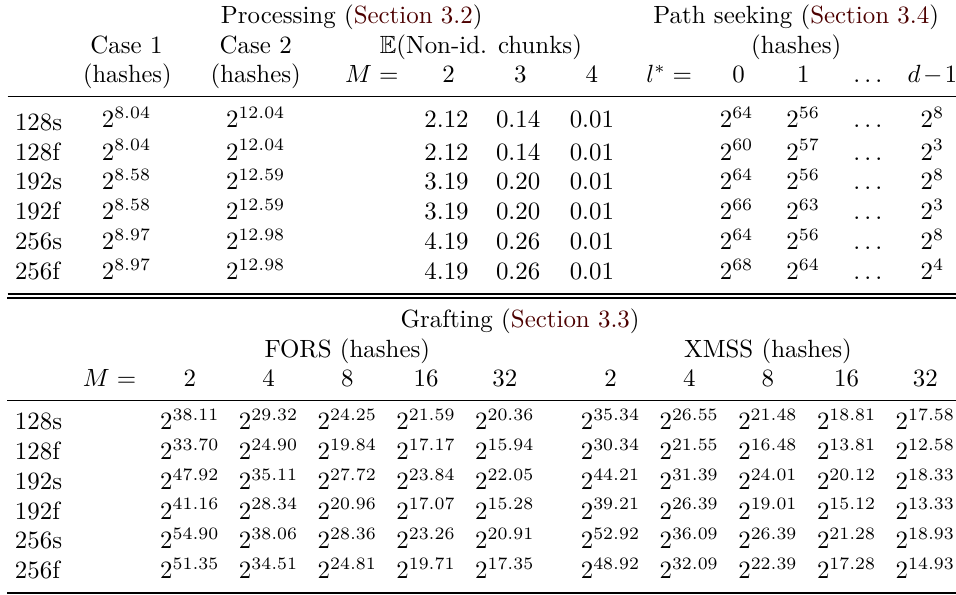
Table 2: Average complexity of each step of the universal forgery for all SPHINCS + parameters (the ‘f’ instances stand for “fast”, while the ‘s’ instances stand for “small”). Processing (Section 3.2) Path seeking (Section